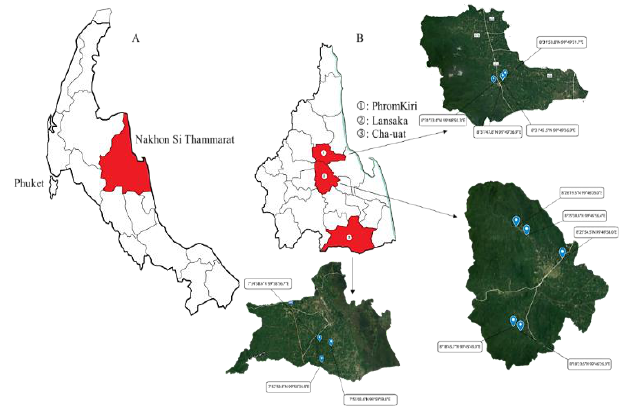
Figure 3: Nakhon Si Thammarat province and the sampling sites, A: presented the location of Nakhon Si Thammarat (in red) in the southern part of Thailand, B: showed where the sampling locations were in the districts of Cha-Uat, Lan Saka, and Prom